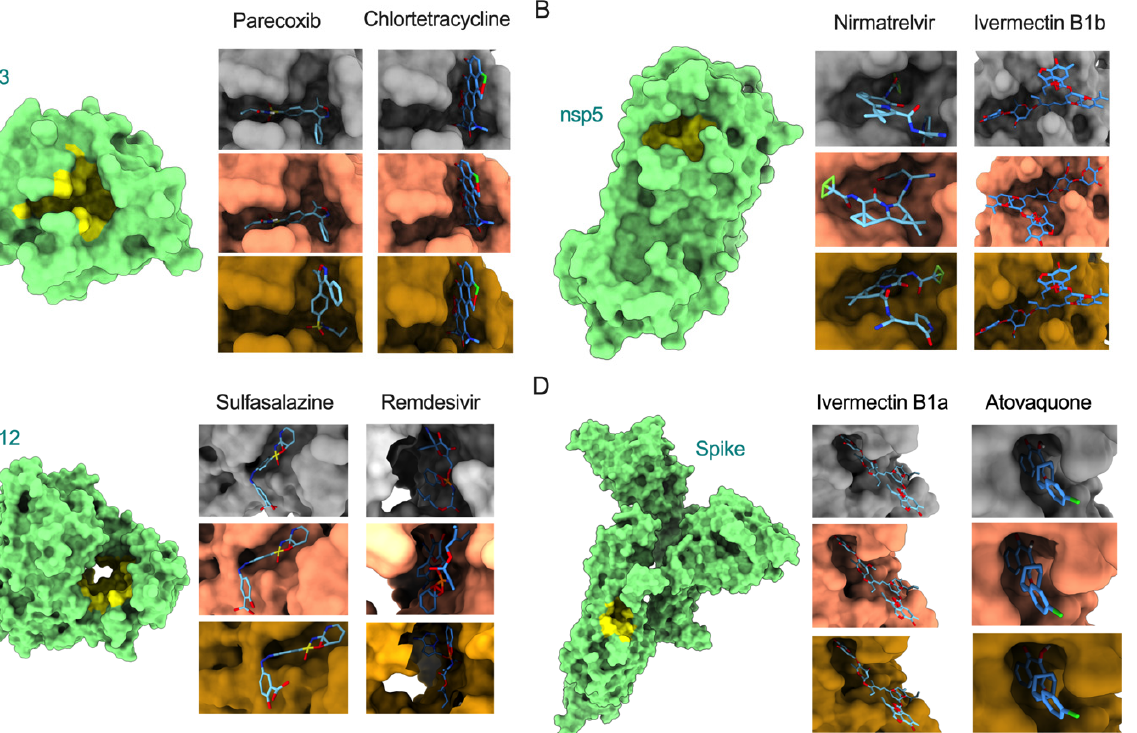
Figure 3. Surface model of binding of inhibitors to the active sites of nsp3, nsp5, nsp12, and spike (models with green color, left). Illustration of docking models (reference = grey; Delta = salmon; Omicron = goldenrod) for binding energy conformations are provided for ( A ) parecoxib and chlor- tetracycline bound to nsp3, ( B ) nirmatrelvir and ivermectin B1b bound to nsp5, ( C ) sulfasalazine and remdesivir bound to nsp12, and ( D ) ivermectin B1a and atovaquone bound to spike. Table 1. Molecular docking analysis of eight antiviral compounds (parecoxib, chlortetracycline, ivermectin B1a, ivermectin B1b, sulfasalazine, remdesivir, atovaquone, and nirmatrelvir) against their respective SARS-CoV-2 target proteins (nsp3, nsp5, nsp12, and spike). The 3D structure of four target proteins of the reference strain and the two variants Delta and Omicron were modeled before docking with inhibitors. The hydrogen bond-forming residues from the pool of interacting residues of each target protein are highlighted in bold. While we display all interacting residues from the reference strain, the interacting residues that were different from the reference are displayed for two variants for better readability. Refer to Figure S1 for visualization of inhibitors and target interac- tions. Protein